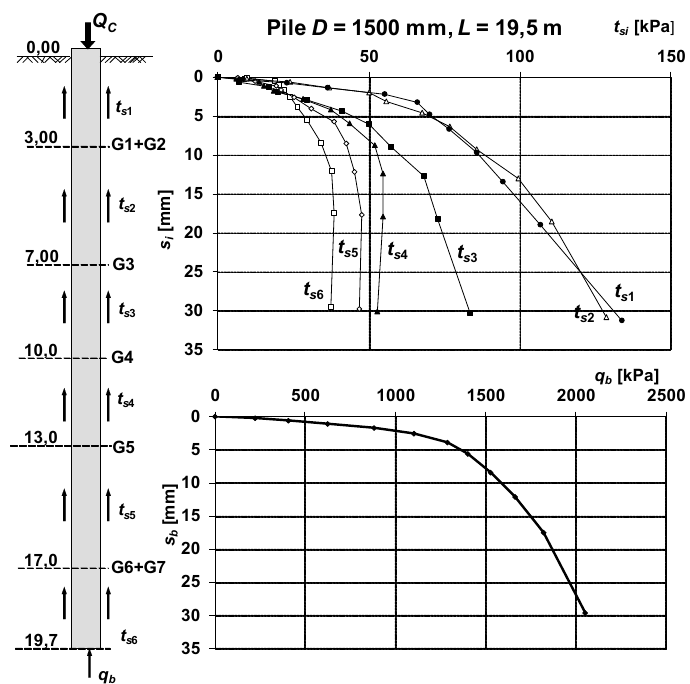
Fig. 4. Unit skin friction distribution t si [kPa] and unit load under the pile base q b